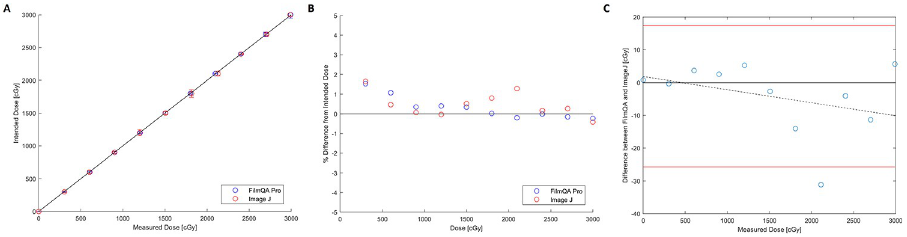
Fig 6. EBTXD for the 0–3000 cGy dose range. A) Measured vs. intended dose. The solid line has a slope of one and is meant to guide the eye, as points falling on it indicate perfect agreement. Error bars represent 3 standard deviations. B) Percent difference from intended dose. C) Bland-Altman Plot.